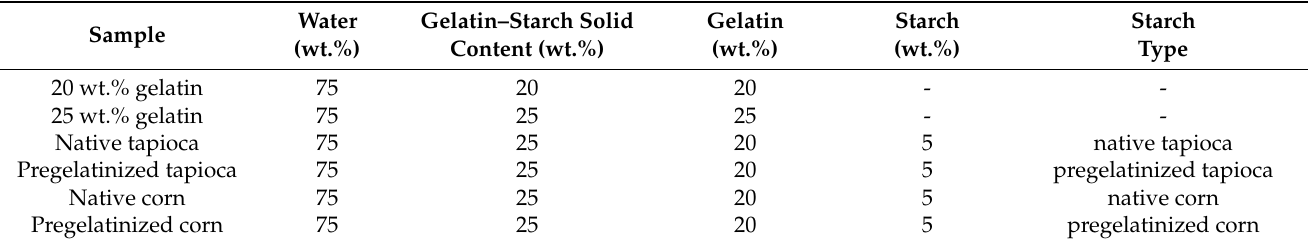
Table 2. Composition of the formulated